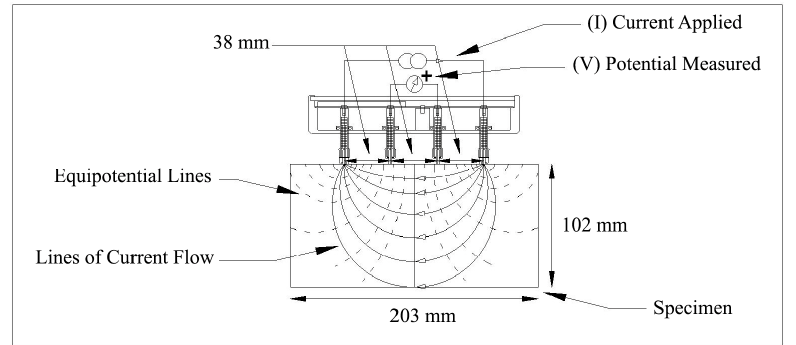
Figure 6. Four-point Wenner probe array test setup.